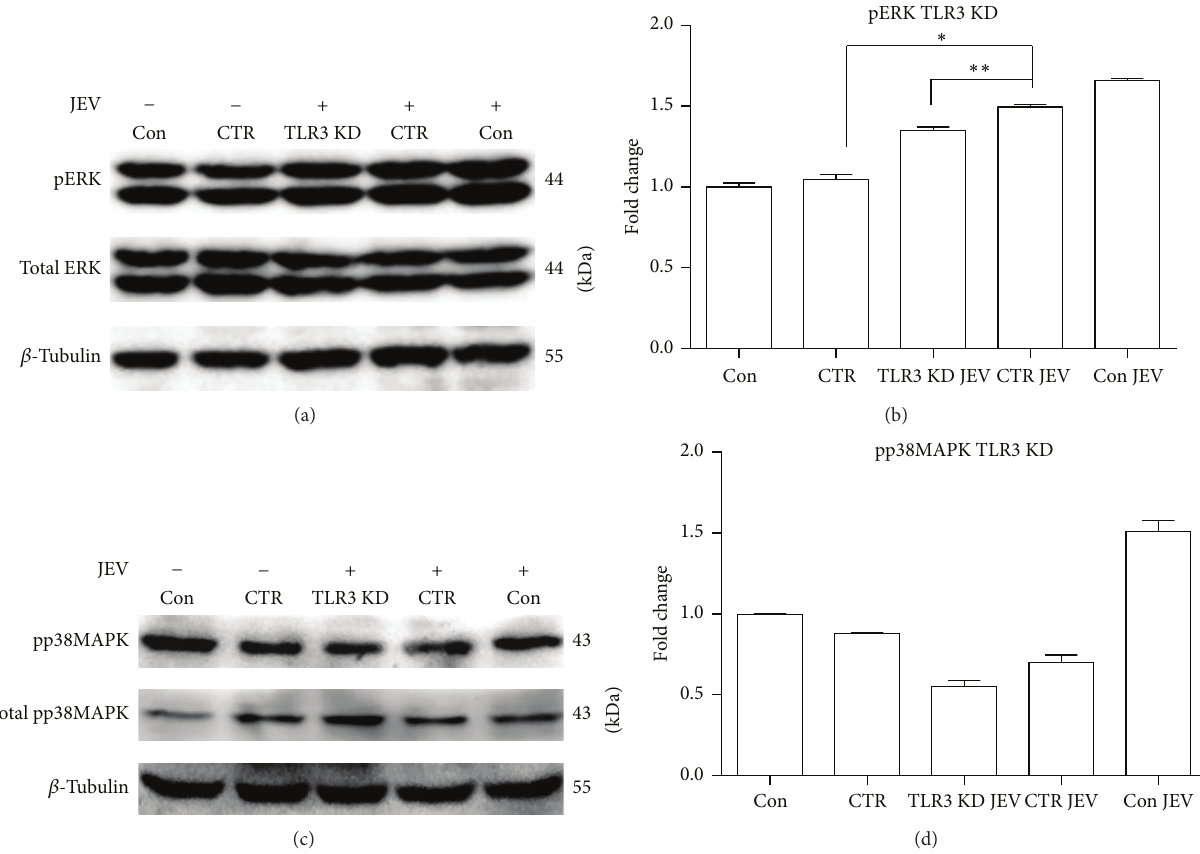
Figure 6: Knockdown of TLR3 decreases the activation of p38MAPK and ERK in JEV-infected BV-2 cells. BV-2 cells were transfected with TLR3 shRNA (TLR3 KD) or negative control shRNA (CTR) and then infected with JEV at an MOI of 1. (a, c) Phospho-ERK (pERK) and phospho-38MAPK (pp38MAPK) were detected with western blotting at 5 hpi. (b, d) The protein levels were quantified with immunoblot scanning and normalized to the amount of 𝛽 -tubulin. Error bars represent the standard deviation of results from three independent assays ( ∗ 𝑃 < 0.05 ; ∗∗ 𝑃 < 0.01